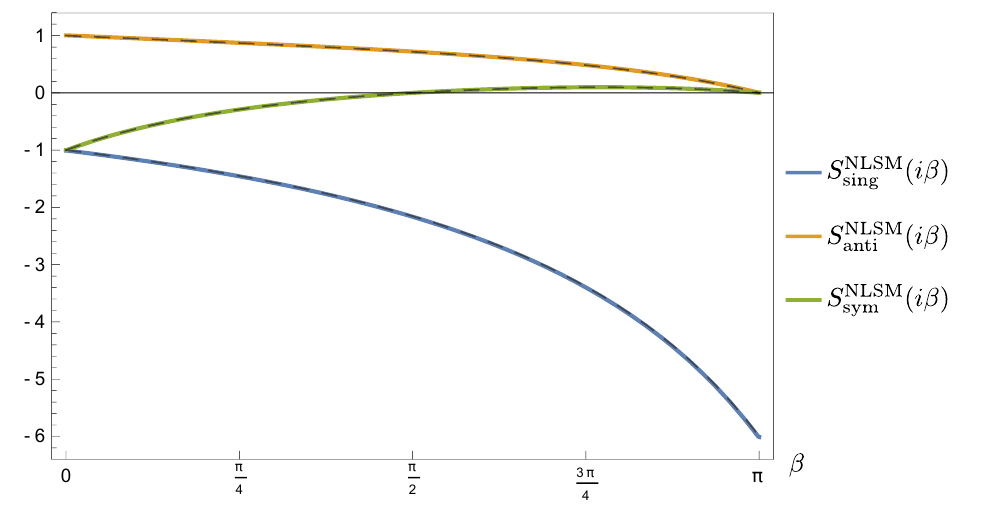
Figure 6 . Numerical results imposing the NLSM zero at S sym ( i(cid:21) GN ) and maximizing S anti ( i(cid:25)= 2) for N = 6 and n grid = 40. The singlet, anti-symmetric and symmetric S-matrices are plotted respectively in blue, orange and green. These curves perfectly agree with the solution (2.8) in dashed lines. For this value of N the zero sits exactly at the middle of the strip at (cid:18) = i(cid:25)= 2. Similar plots are obtained for any N (cid:21) 5 where only the position of the latter zero